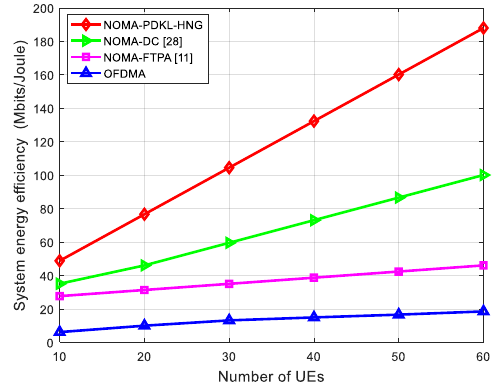
Figure 4. System sum rate vs. number of UEs per BS.